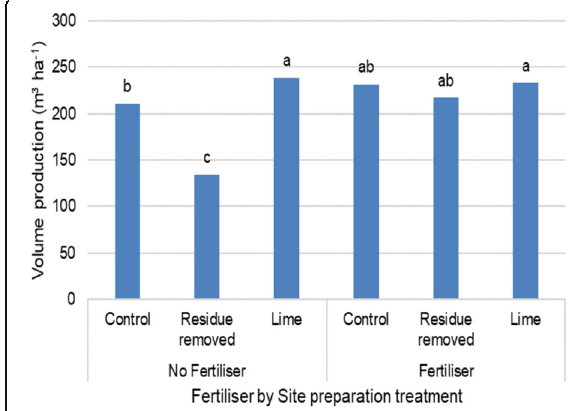
Fig. 1 Interaction between fertiliser and site preparation treatment on volume production at age 9 years on site A9, third rotation plot